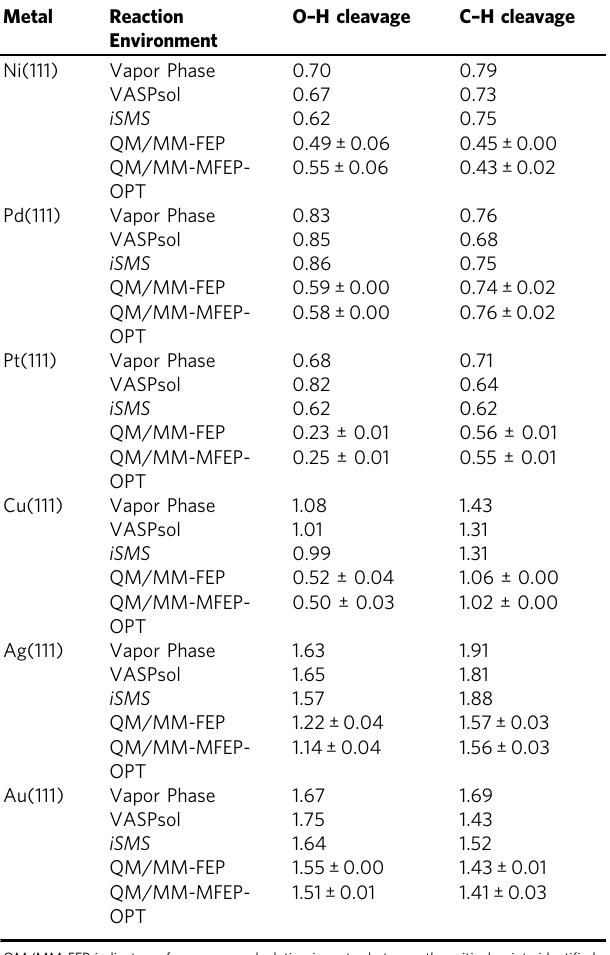
Table 1 Free energies of activation of O – H bond cleavage (CH 2 OHCH 2 OH** + * ↔ CH 2 OCH 2 OH** + H*) and C – H bond cleavage (CH 2 OHCH 2 OH** + * ↔ CHOHCH 2 OH ** + H*) of ethylene glycol in gas- and aqueous-phase environments over the (111) surface facet of six transition metals at 423